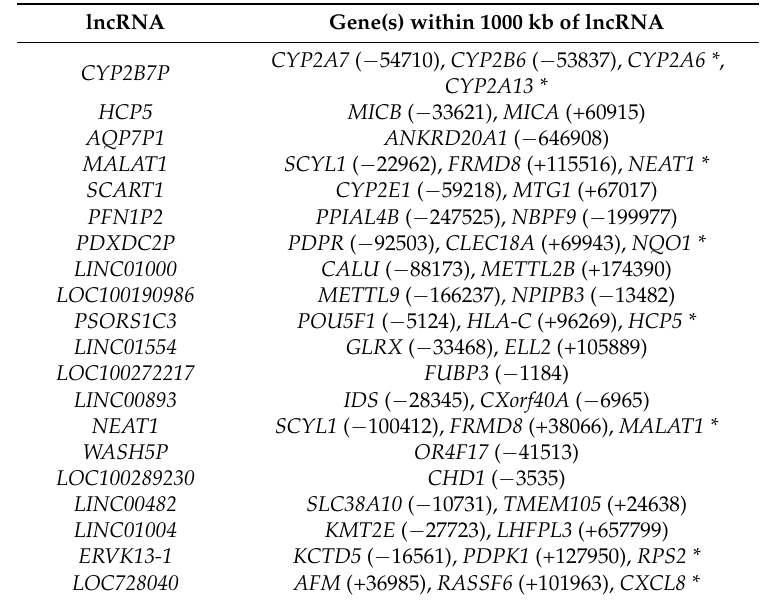
Table 2. Protein-coding and non-protein coding genes neighboring (within 1000 kb) the 20 lncRNAs whose transcripts were up- or downregulated by 100 µ M DEET using GREAT algorithm parameters. The GREAT algorithm defines neighboring genes as those whose transcription start site (TSS) is within 1000 kb of the input lncRNAs. lncRNA = long non-protein coding RNA; kb = kilobases. All gene names are HUGO gene nomenclature committee (HGNC) gene